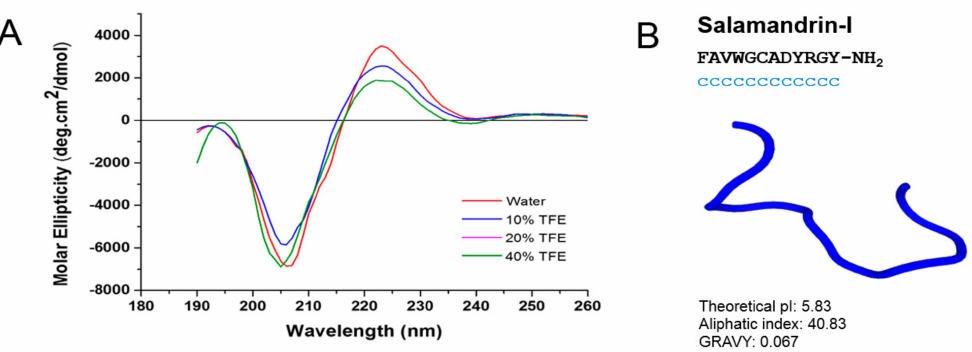
Figure 3. Structural analysis of salamandrin-I peptide. ( A ) Circular dichroism of peptide in aqueous solution and 10%, 20%, and 40% of 2,2,2-trifluoethanol (TFE) solutions (red, blue, pink, and green, respectively). ( B ) Theoretical salamandrin-I 3D structure prediction (c, random coil representation / GRAVY, Grand Average of